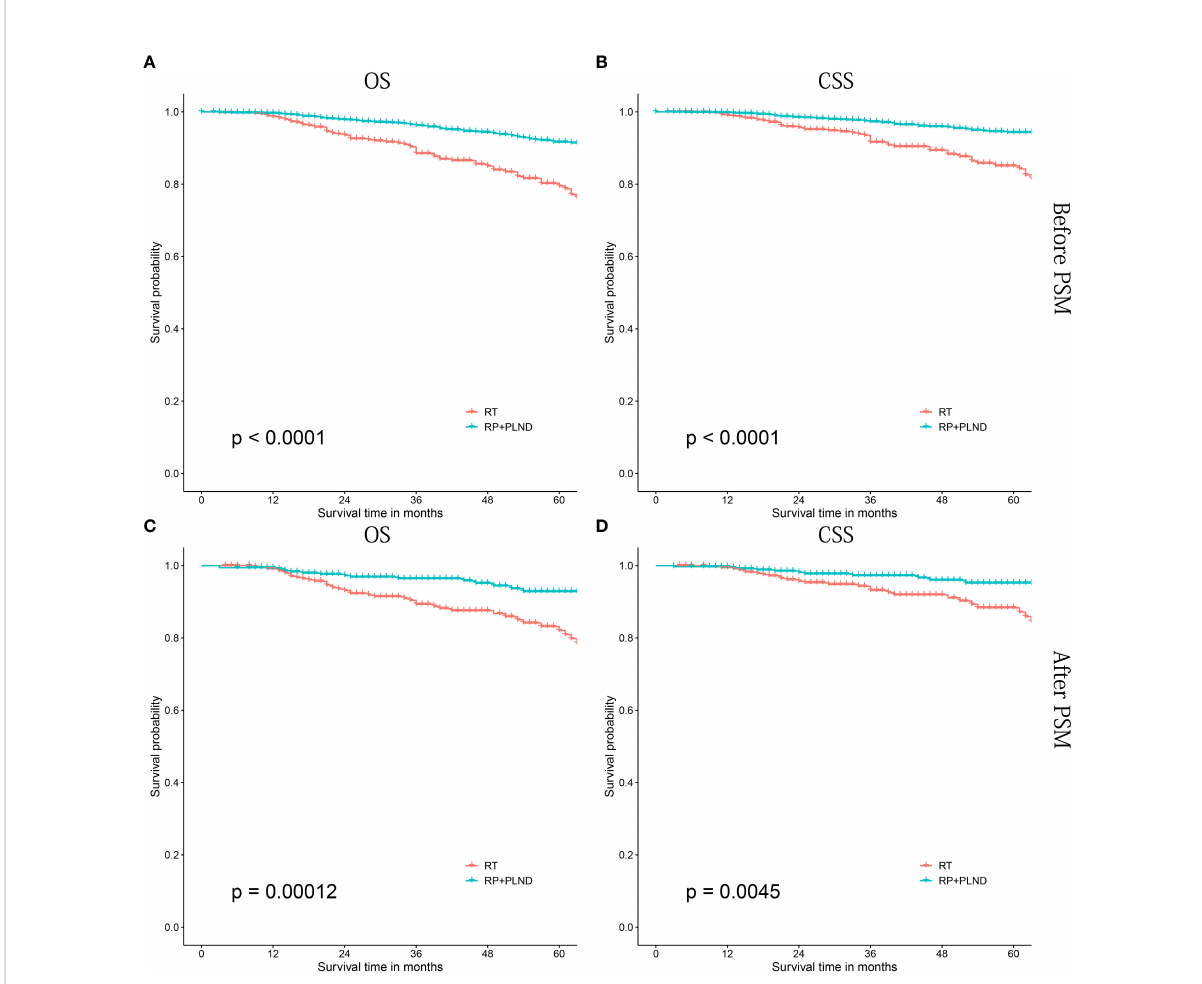
FIGURE 4 Kaplan-Meier survival curves of cN1M0 prostate cancer patients treated with RP+PLND versus radiation therapy. (A, B) OS and CSS before PSM; (C, D) OS and CSS after PSM. RP, radical prostatectomy; PLND, pelvic lymph node dissection; OS, overall survival; CSS, cancer-speci fi c survival; PSM, propensity score